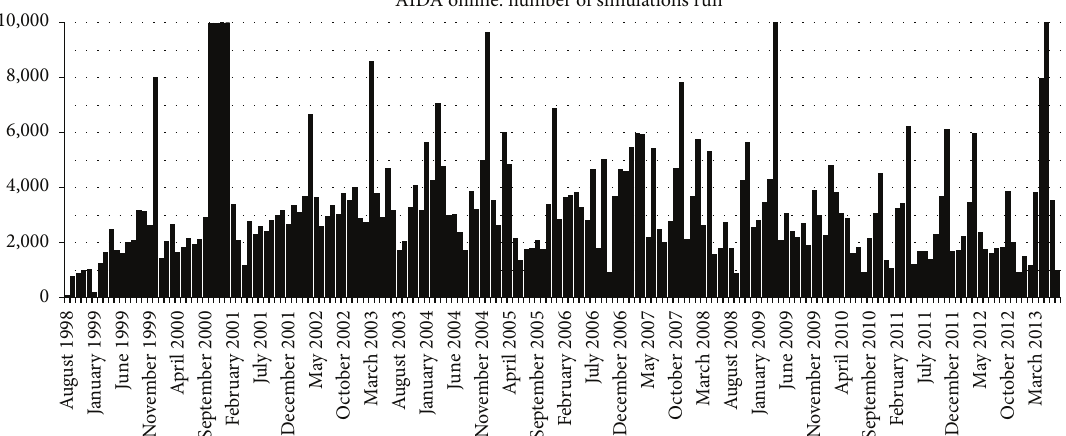
Figure 8: Usage of AIDA online showing the number of simulations run per month versus time. (a) January 1999—server hosting “AIDA online” version 1 crashed, and therefore the facility was unavailable for much of the month. (b) October 2000 to January 2001—simulated blood glucose data harvested from AIDA online by researchers at NASA for training and testing an insulin-dosage adjustment decision support prototype. Over 68,000 simulations were run during this time. Further information available at http://www.2aida.org/nasa. to the website have been logged from over 115